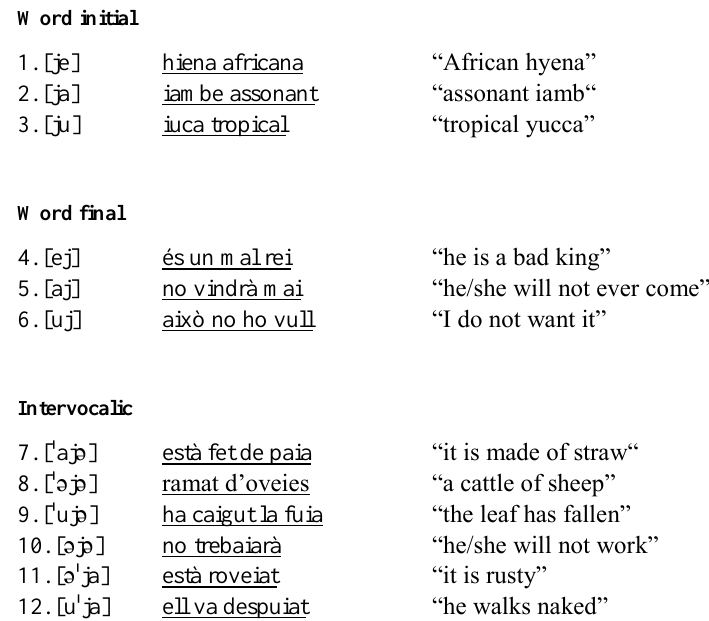
TABLE I. List of sequences represented in dialectal Catalan